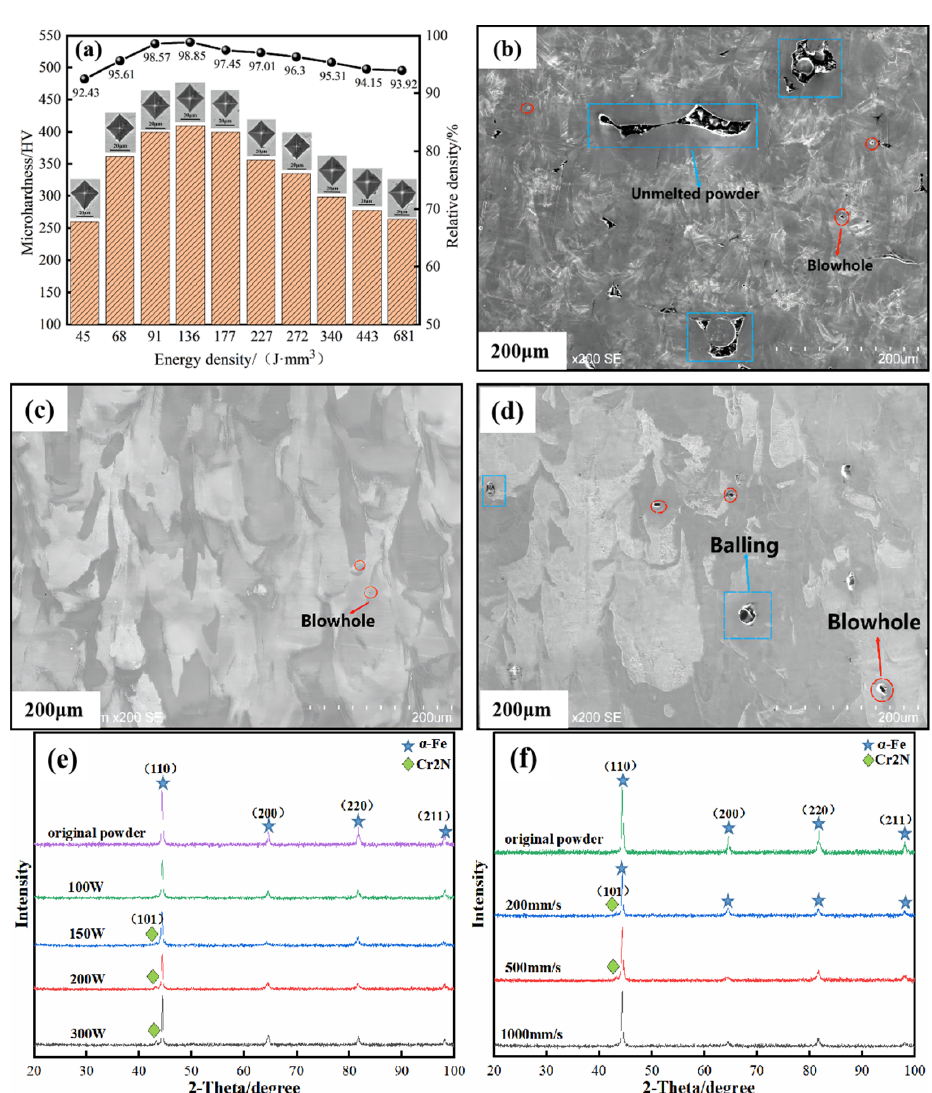
Figure 11. Microhardness distribution of the samples formed at di ff erent energy densities: ( a ) microhardness; ( b ) micromorphology of sample at 45 J/mm 3 ; ( c ) micromorphology of sample at 136 J/mm 3 ; ( d ) micromorphology of sample at 681 J/mm 3 ; ( e ) XRD test at di ff erent scan speed; ( f ) XRD test at di ff erent laser power.